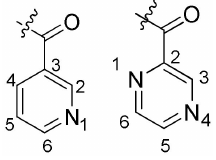
Figure 3. Substituent R 3